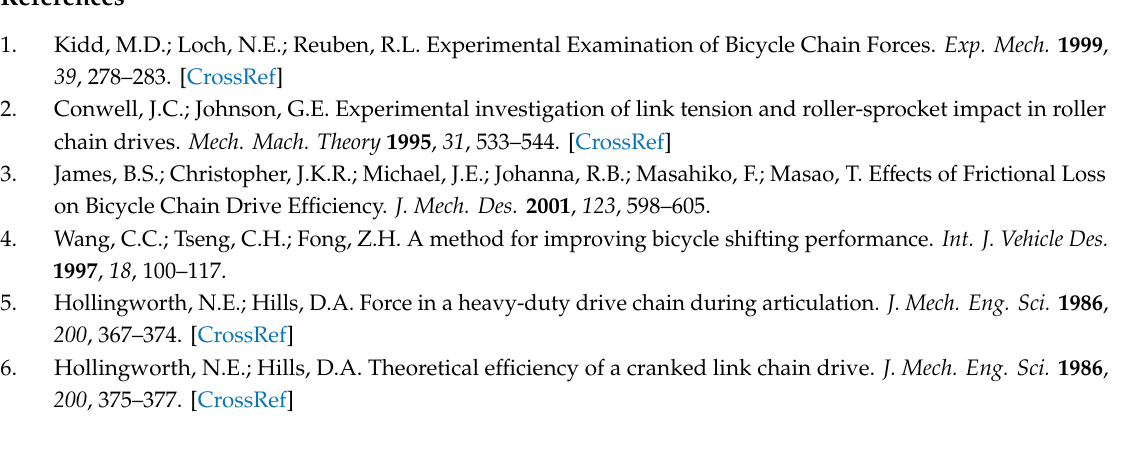
Figure 13. Chain drive efficiencies for different center distances between sprockets with an offset angle.